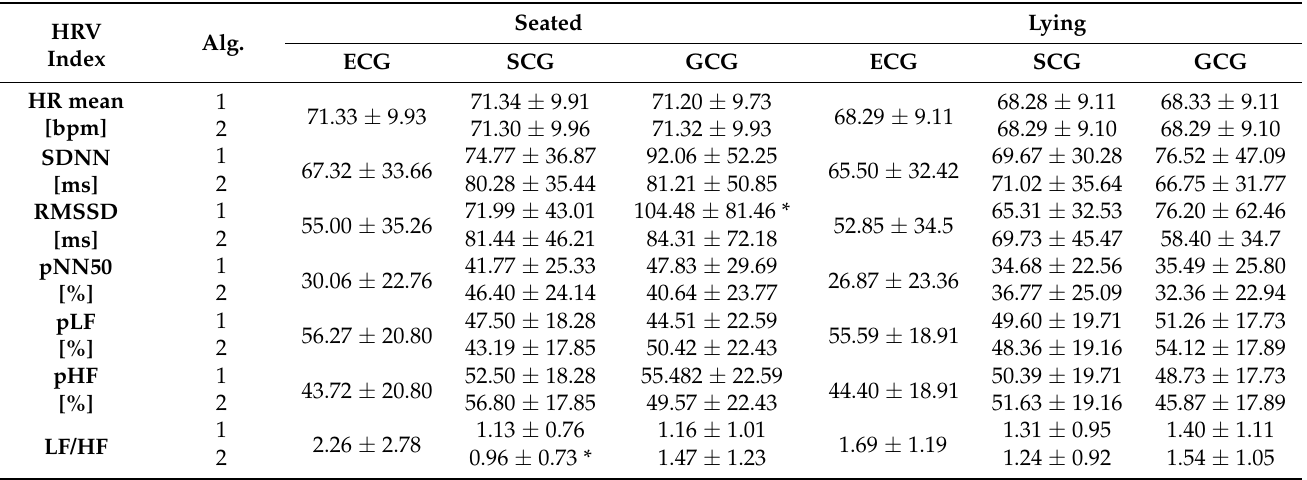
Table 2. Mean and standard deviation for all postures and subjects of HRV indexes related to time (SDNN, RMSSD, PNN50) and frequency (LF, HF, and LF/HF) domain analysis related to algorithms 1 and 2. * means statistically significant ( p < 0.05).